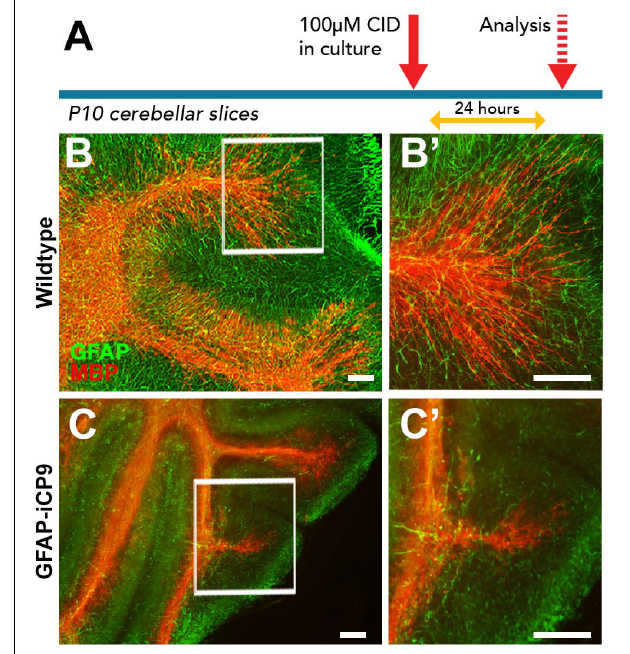
FIGURE 6 | Astrocyte loss in ex vivo cerebellar slice cultures resulted in disruption of myelin integrity. (A) Experimental design. (B,C) Representative images of cerebellar slice cultures co-immunolabeled for MBP (red) and GFAP (green). Compared to controls (B,B’) the organization of myelin in GFAP-iCP9 derived cerebellar slice cultures is compromised following CID induced astrocyte loss (C,C’) . Scale bars 100 µ